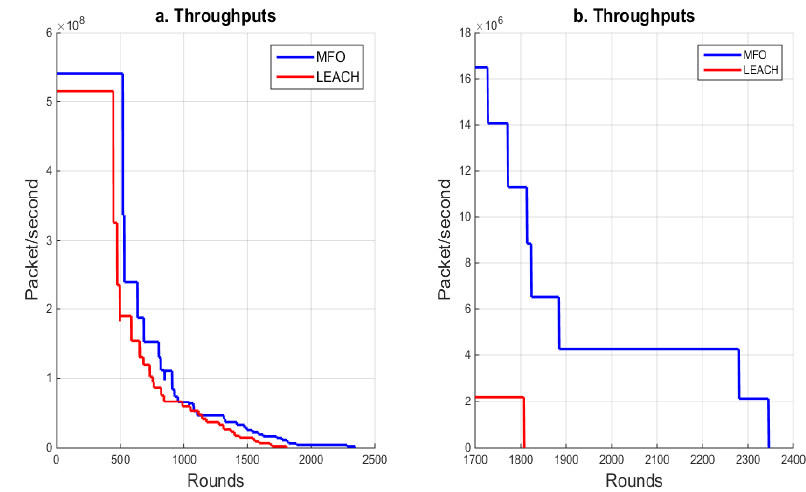
higher than that of the LEACH method, as shown in Figure 8b.